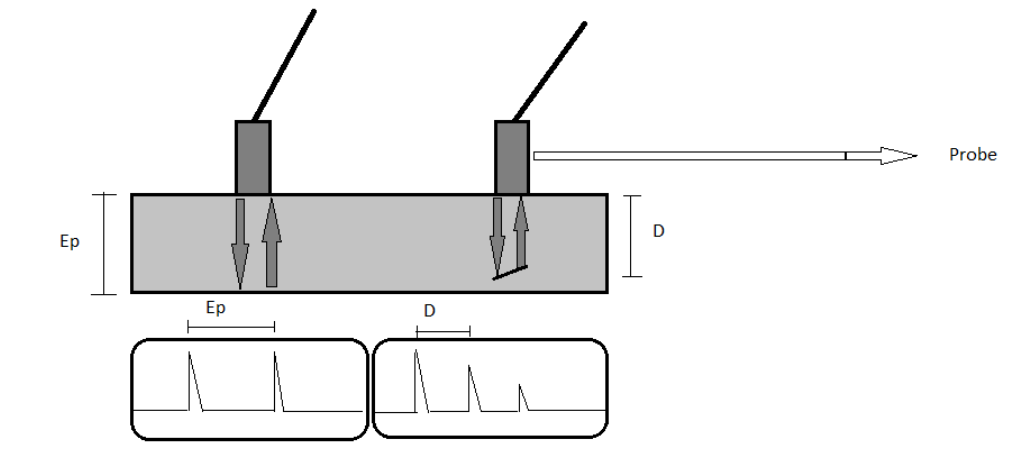
Figure 1. Basic principle of ultrasonic